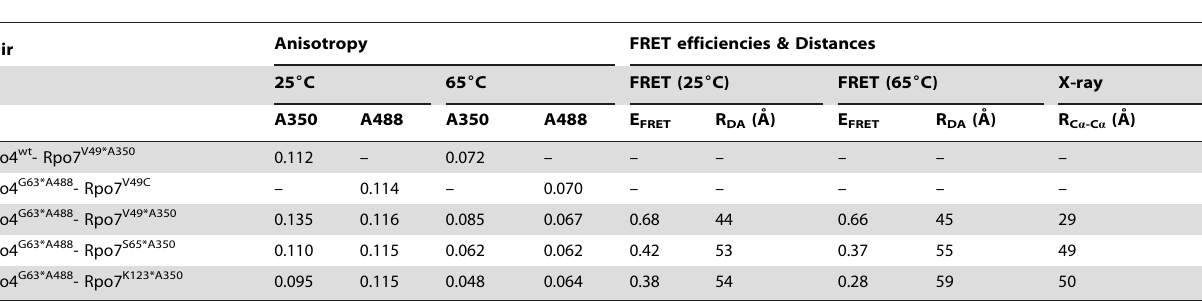
Table 1. Anisotropy and distance data from ensemble FRET measurements carried out at 25 u C and 65 u C.